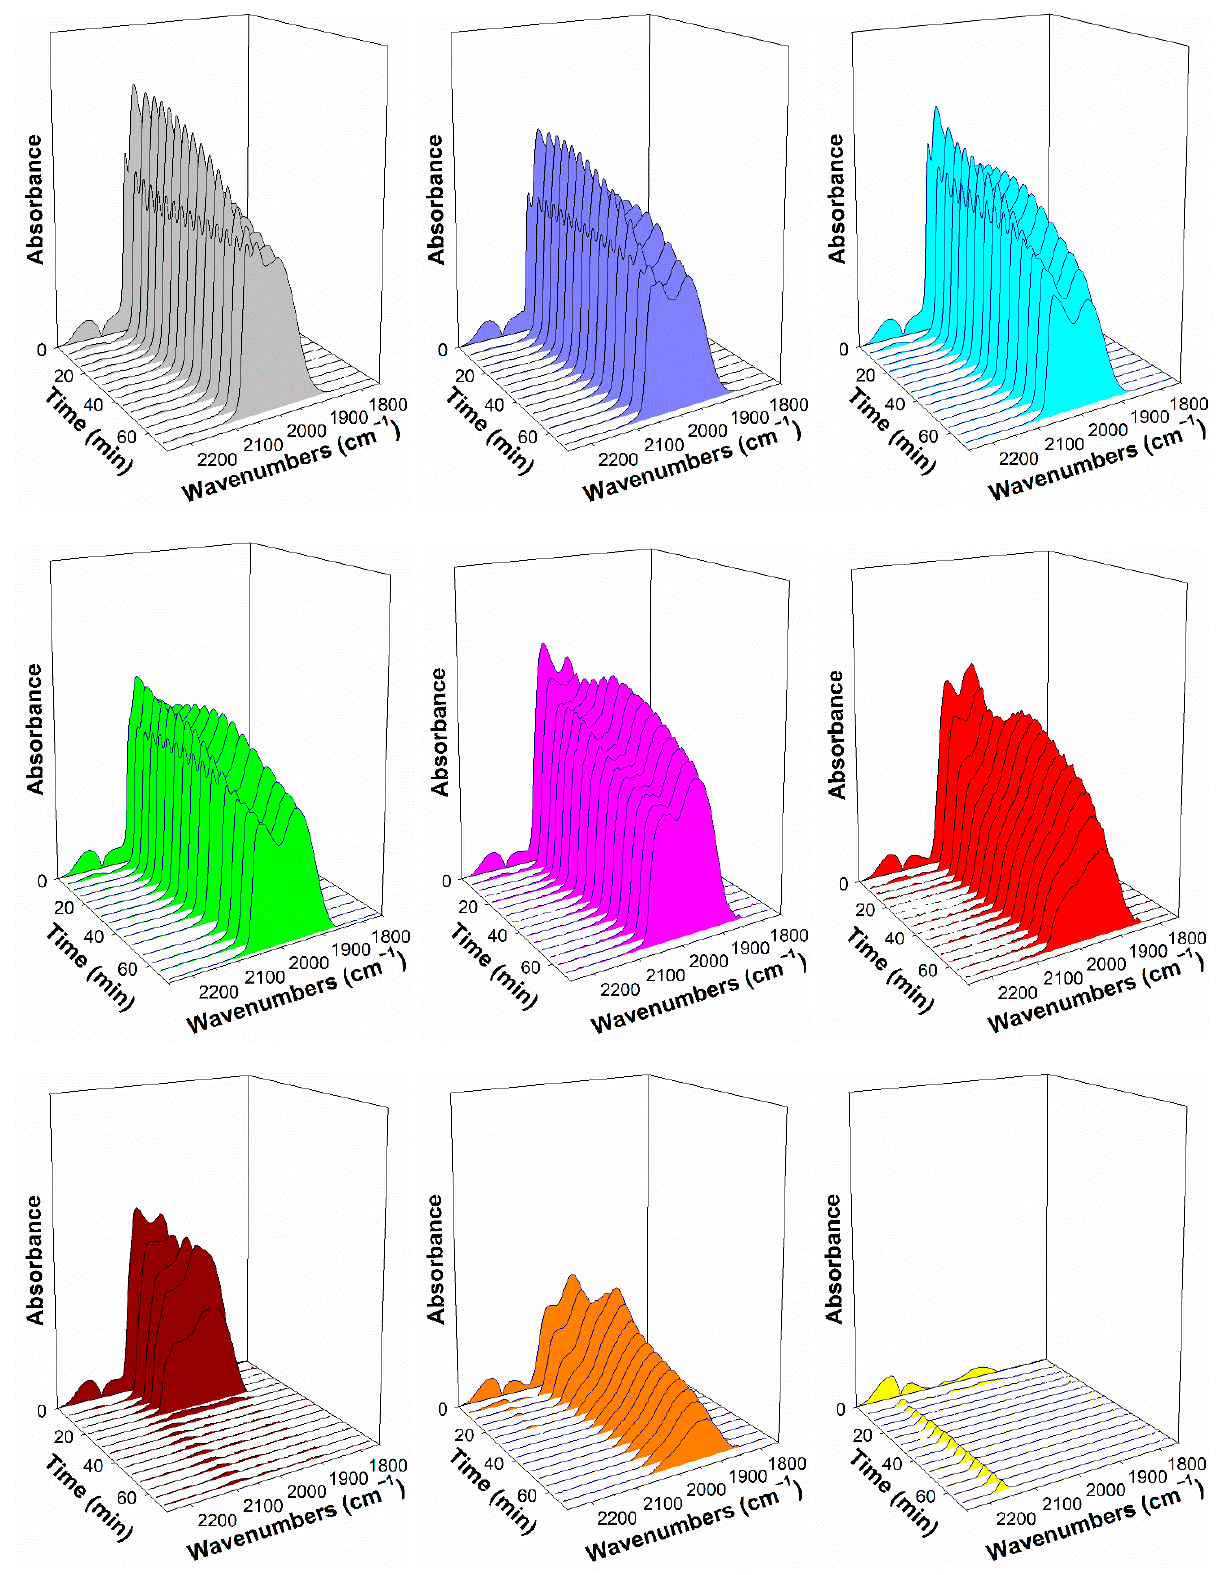
Figure 15. Response of the Pt-CO band in steam at 130 ◦ C, where the maximum in the y-axis is 0.70, including ( gray ) 2%Pt/ZrO 2 , and the same catalyst doped with ( periwinkle ) 0.55%Rb, ( cyan ) 0.93%Rb, ( green ) 1.86%Rb, (pink) 2.79%Rb, ( red ) 3.72%Rb, ( dark red ) 4.65%Rb, ( orange ) 5.58%Rb, and ( yellow ) 9.29%Rb.